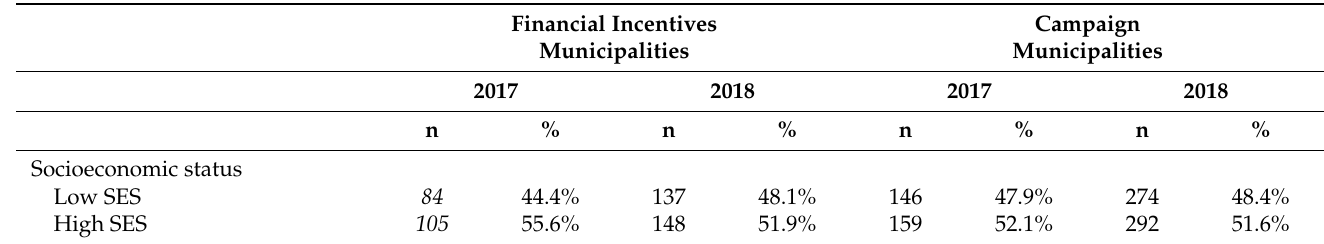
Table 2. Recruitment of smokers in the FIMs and CAMs in the year of intervention (2018) and the year before (2017). Data are presented according to socioeconomic status (SES).